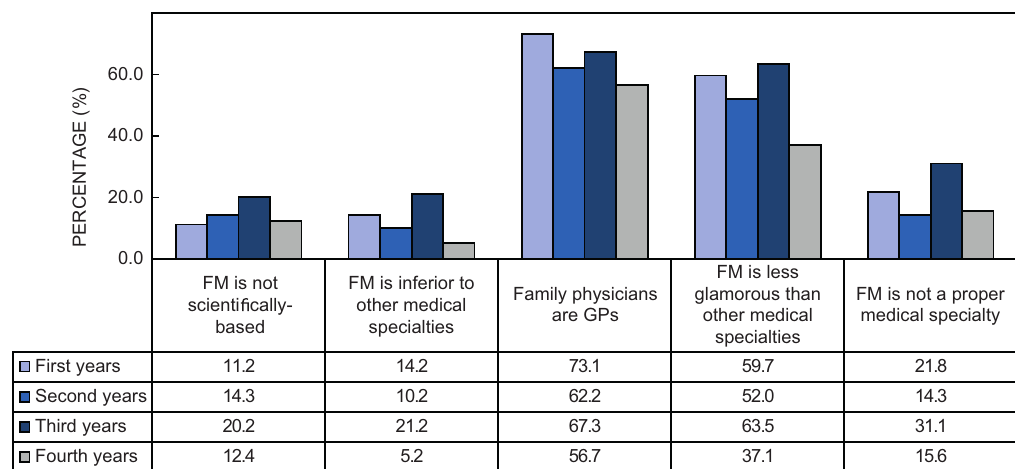
Figure 3: Percentage of undergraduate students who agreed with the five statements on Family